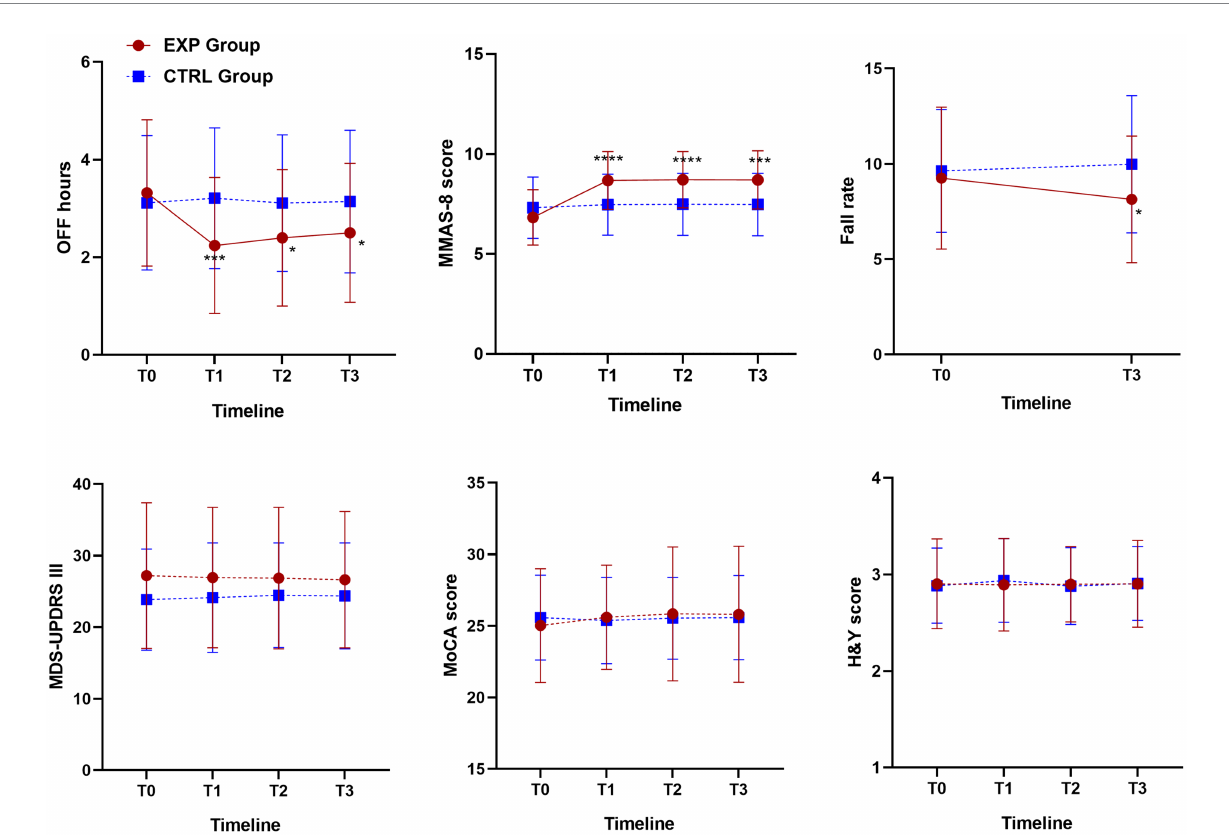
FIGURE 4 Motor and non-motor outcome measures of education therapy: OFF hours, MMAS-8, UPDRS III, MoCA and H&Y at baseline (T0), 6-weeks (T1, EoS), 12-weeks (T2) and 24-weeks (T3) follow-up for all participants and comparison between intervention and control groups. One-way ANOVA, p -value <0.05. For fall rate, outcome measures of education therapy referred to 6-months before the baseline assessment (T0, Falls-6 m) and 24-weeks FU (T3). One-way ANOVA, p -value < 0.05. According to GraphPad Prism 7 software, * p -value from 0.01 to 0.05 (Significant), *** p -value from 0.0001 to 0.001 Extremely significant, **** p -value <0.0001 extremely